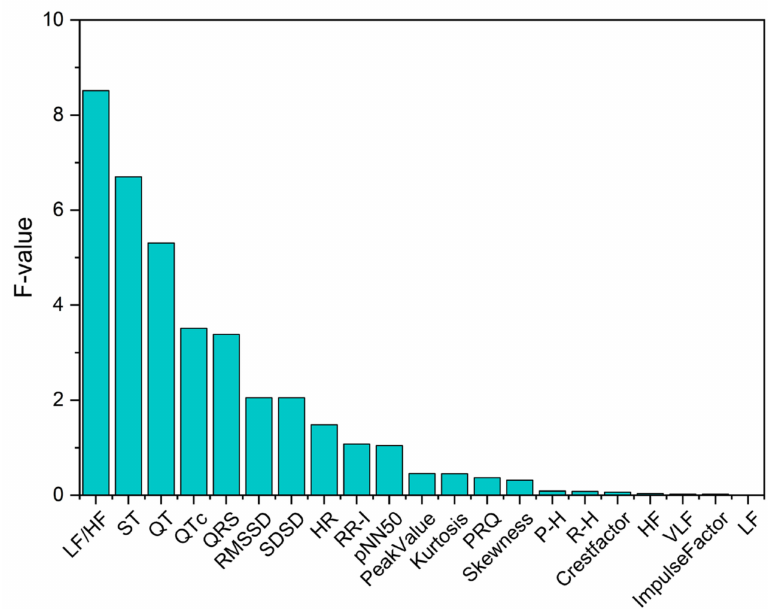
Figure 3. Ranking of overall features based on the ANOVA F-test. LF: low-frequency, HF: high- frequency, QTc: corrected QT interval, RMSSD: root mean square of the sum of the squares of differences between adjacent RR intervals, SDSD: standard deviation of adjacent RR intervals dif- ferences, HR: heart rate, RR-I: RR intervals, pNN50: percentage of intervals greater than 50 ms different from the proceeding interval, PRQ: time interval measured from the beginning of the P wave to the peak of the R wave, P-H: amplitude of P wave, R-H: amplitude of R wave and VLF: